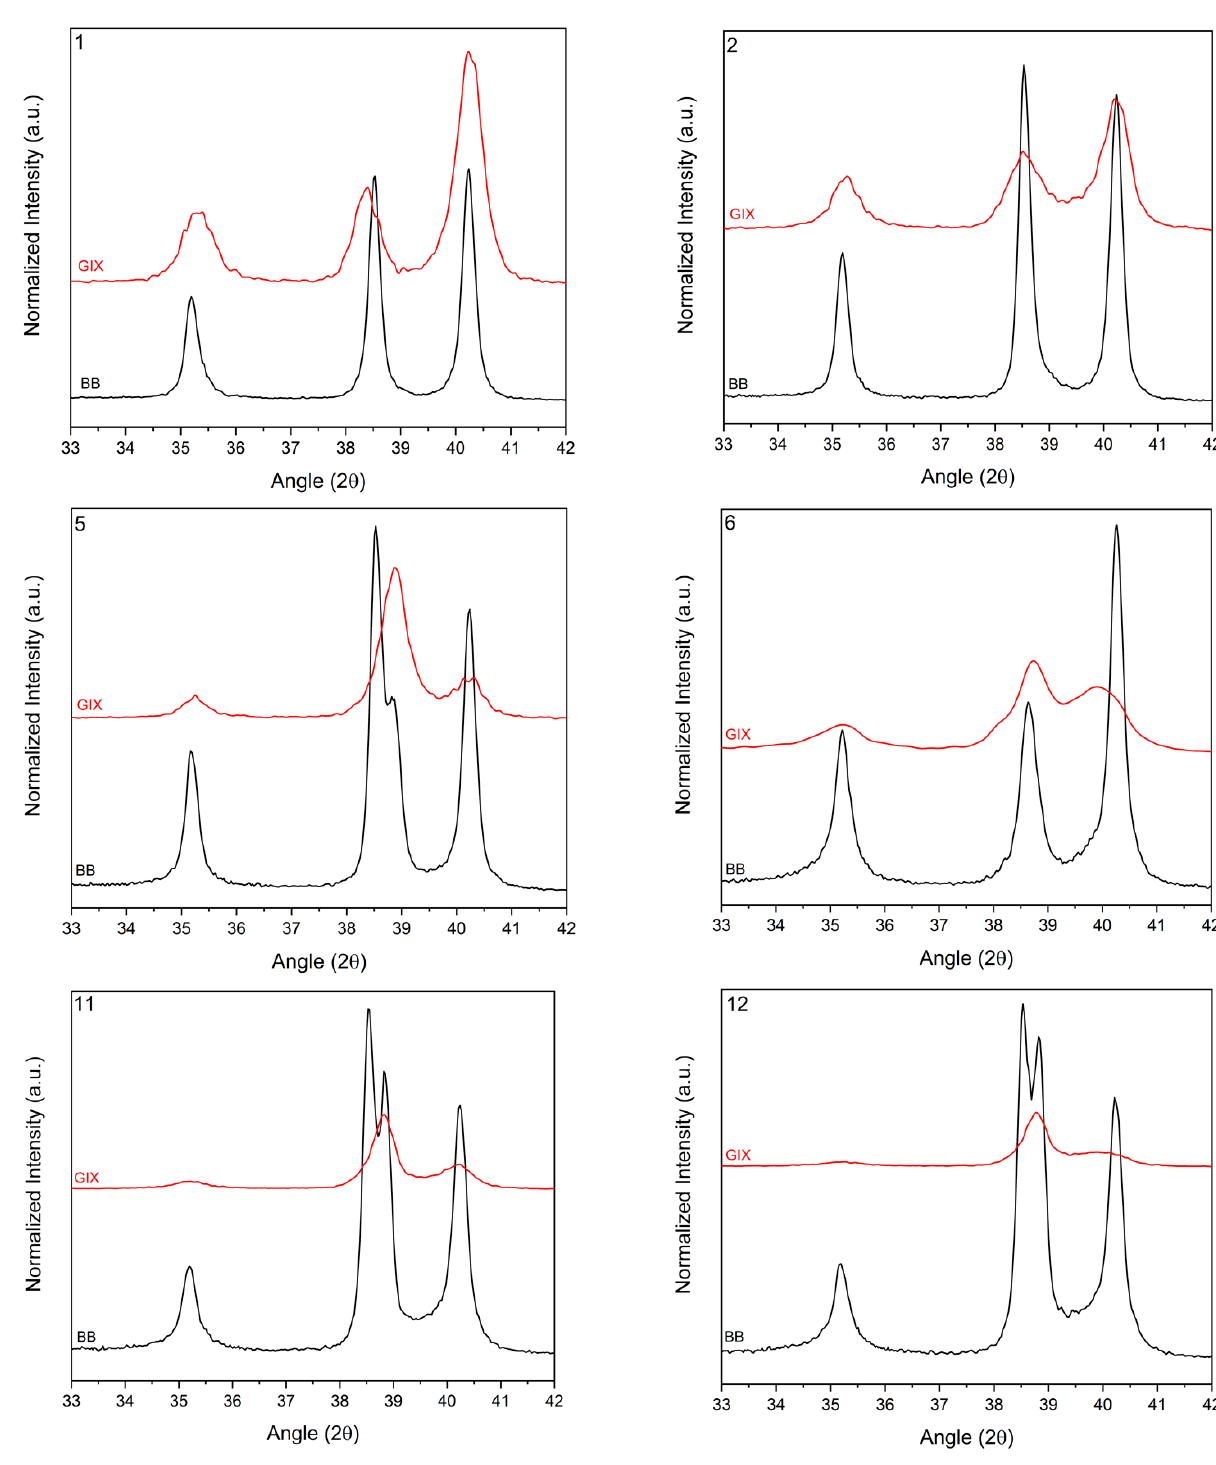
Figure 7. Grazing incidence angle (GIX) vs. Bragg–Brentano (BB) spectra of set I samples, as indicated by the number in the upper left corner of the plots.